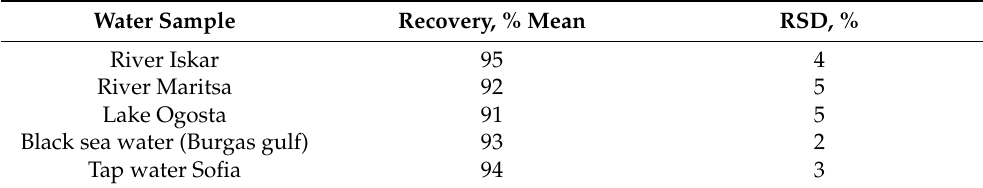
Table 5. Recoveries for U determination in different types of surface waters (three parallel determinations). Water Sample Recovery, % Mean RSD, % River Iskar